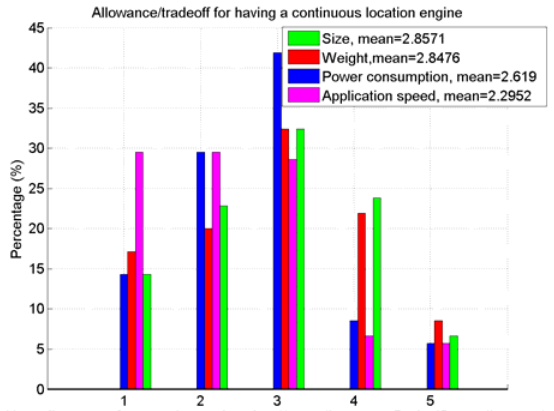
Figure 9. User allowances in order to have the location estimation engine working continuously on your mobile device (and not only on demand). 1 = 0% allowance, 2 = up to 1% extra; 3 = up to 5% extra; 4 = up to 10% extra; 5 = up to 25%